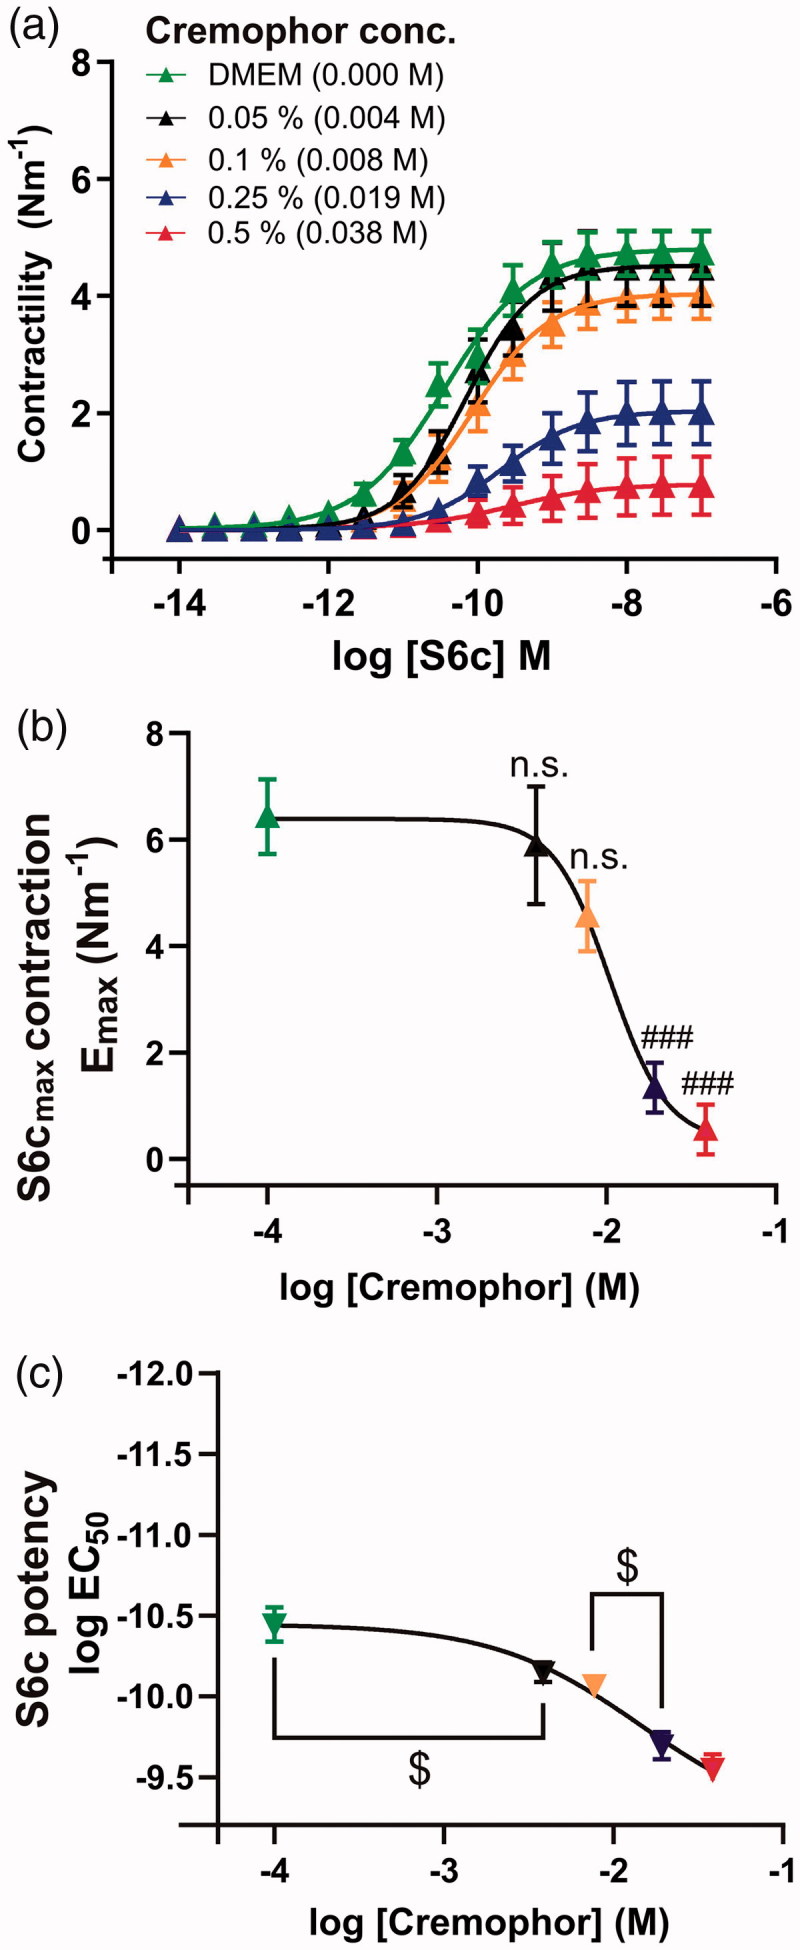
Concentration-dependence of cremophor on S6c-induced contractility after 48 h organ culture. Basilar arteries were incubated with different concentrations of cremophor. (a) Concentration-response curves with S6c show varying log EC50 and Emax values. Correlation between varying concentrations of cremophor with Emax (b) and log EC50 (c) from the concentration-response curves with S6c. Values are listed in the Table S2, one-way ANOVA with Holm-Sidak post-test (###p < .001). $=non-overlapping 95% confidence intervals. Data are expressed as mean ± SEM, n = 6–7.